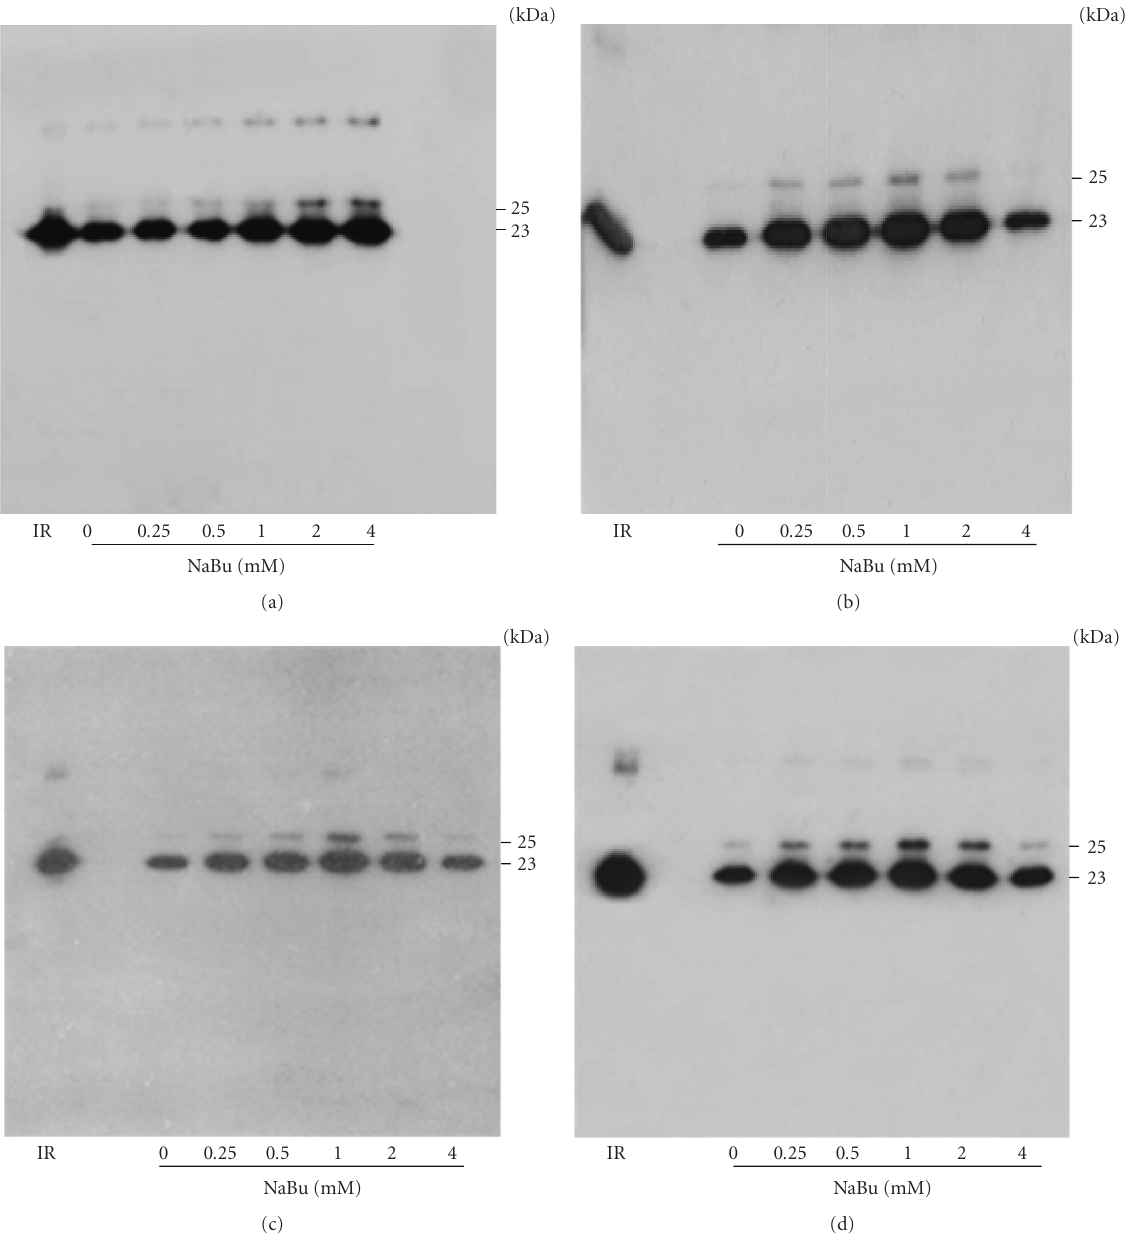
Figure 4: Western blot analysis of hPRL production in CHO cells treated with di ff erent concentrations of NaBu on days 1 (a), 4 (b), 5 (c), and 6 (d). Molecular weights G-hPRL (25kDa) and NG-hPRL (23kDa) are indicated. IR: Internal Reference of periplasmic E. coli- derived